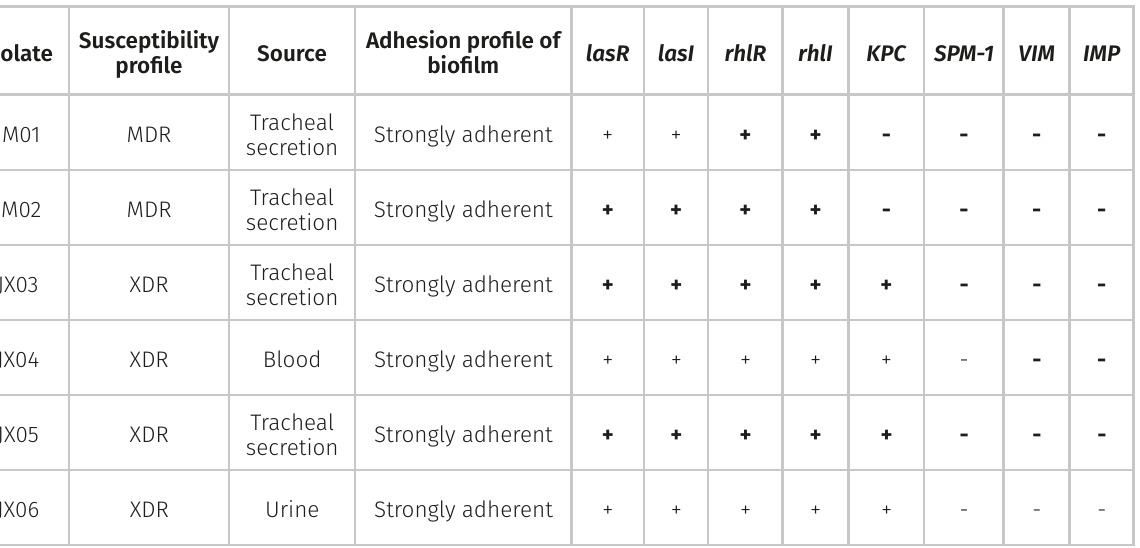
Table III. Phenotypic and genetic characterization of CRPA